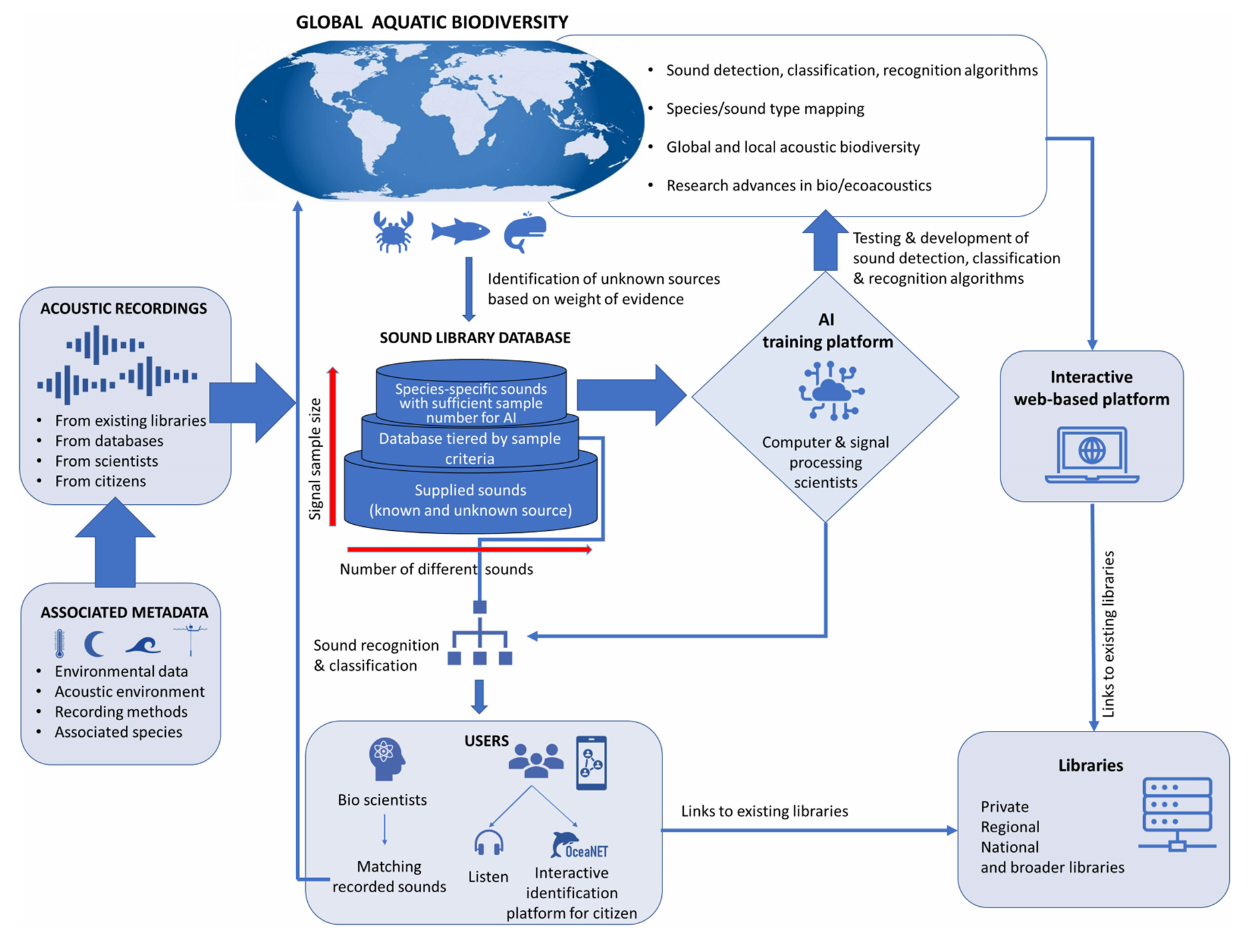
FIGURE 2 | Conceptual diagram of the basic structure and data flow within a potential global integrated library and database sharing